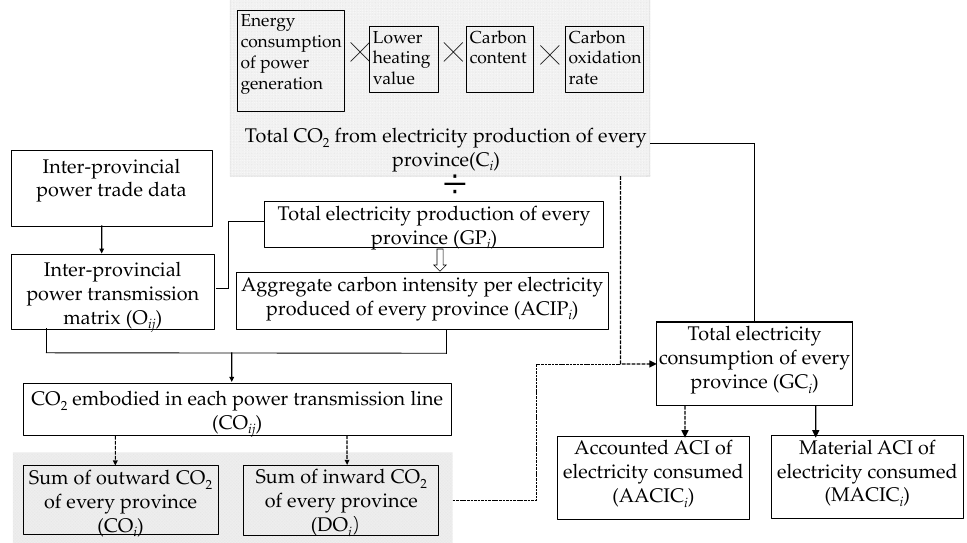
Figure 1. Analysis scheme of this paper.